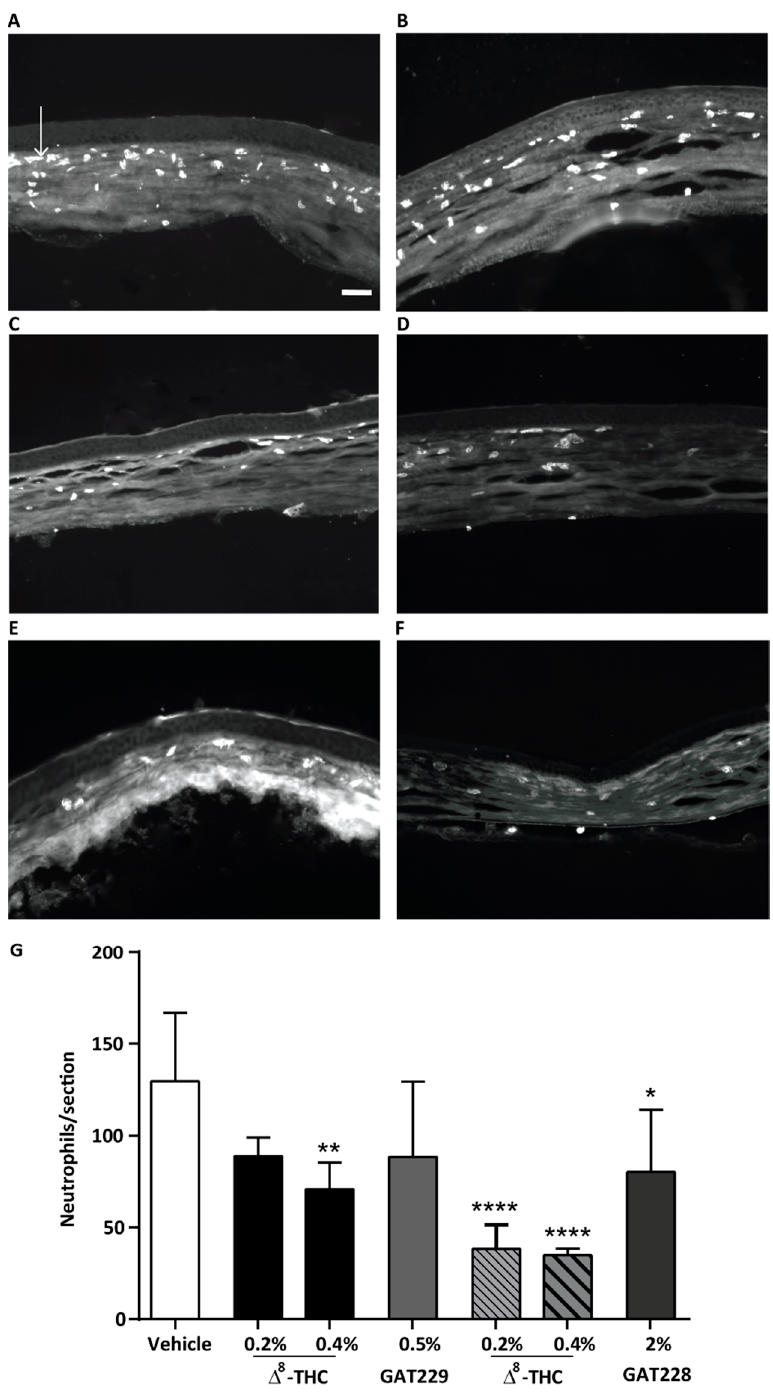
Figure 3. Neutrophil expression in cauterized corneas at 6 h post injury following the topical treatments of drug or vehicle and capsaicin stimulation. Representative images of transverse sections of the central cornea from ( A ) vehicle-treated corneas, ( B ) 0.2% Δ 8 -THC-treated corneas, ( C ) 0.5% GAT229-treated corneas, ( D ) 2% GAT228-treated corneas and ( E ) 0.2% Δ 8 -THC + 0.5% GAT229, ( F ) 0.4% Δ 8 -THC + 0.5% GAT229 and ( G ) effects of topical treatment of WT cauterized eyes with (0.2 and 0.4%) Δ 8 -THC, 0.5% GAT229, 2% GAT228 or, 0.2% or 0.4% Δ 8 -THC + 0.5% GAT229 ( n = 4–6 per group) in neutrophil infiltration compared to vehicle-treated eyes ( n = 7). Values represent mean ± SD. Arrow in ( A ) points to one of many infiltrating neutrophils. Scale bar: 50µm. For statistical analysis one-way ANOVA with Dunnett’s post hoc test (compared to vehicle) was used. * p < 0.05, ** p < 0.01, **** p < 0.0001.